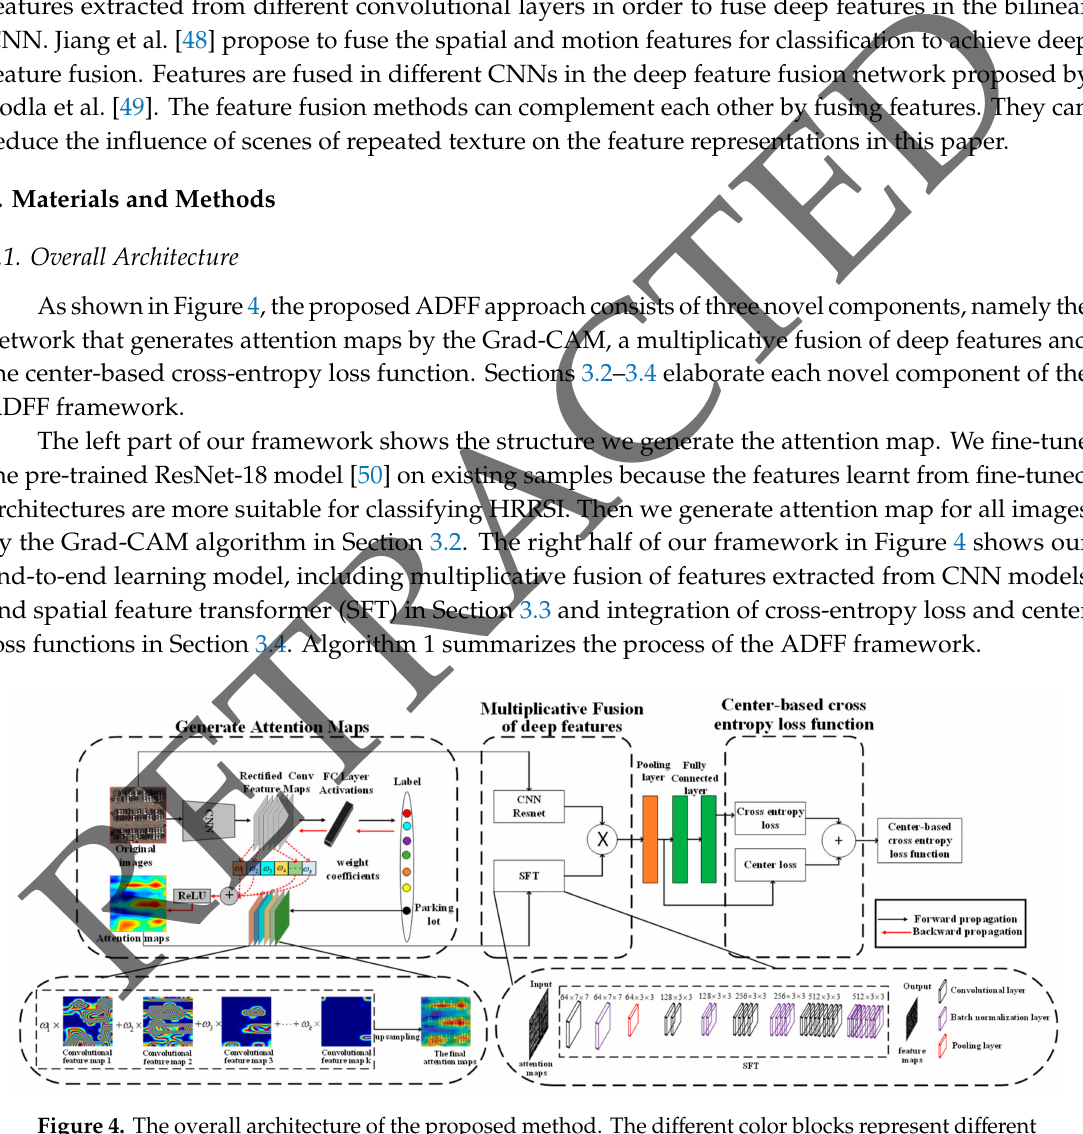
Figure 4. The overall architecture of the proposed method. The di ff erent color blocks represent di ff erent network structure layers,